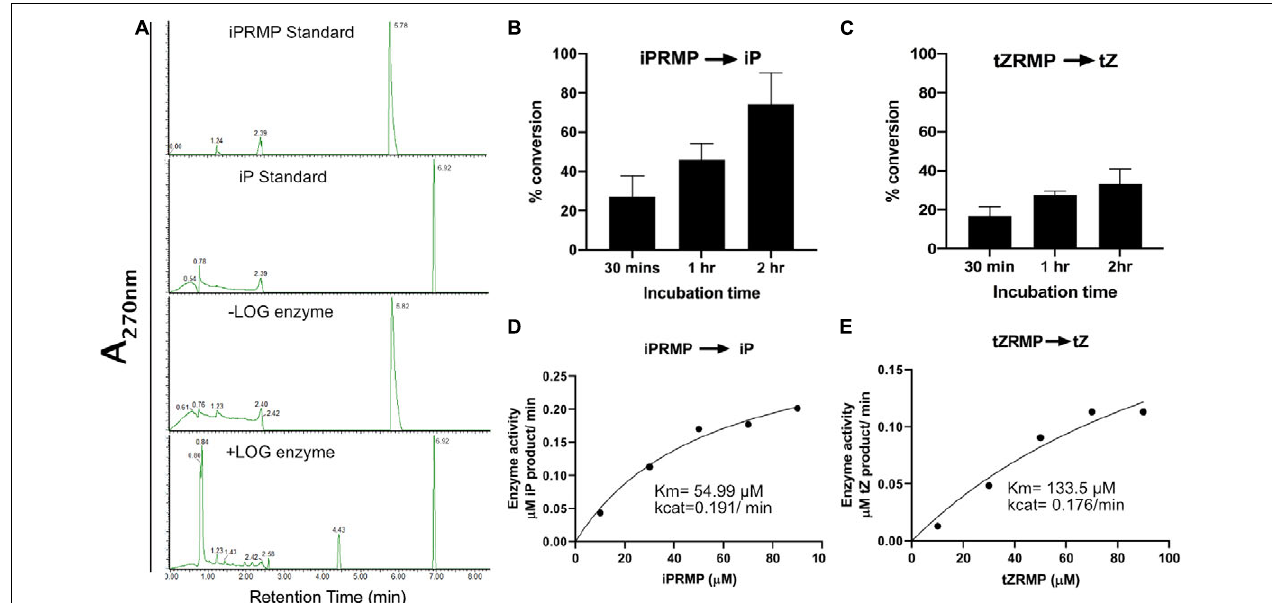
FIGURE 2 | Enzyme assay of CvarLOG1; detection and identification of reaction products. (A) Standards iPRMP and iP, reaction products of iPRMP without LOG and with LOG were separated by UHPLC. Phosphoribohydrolase activity of CvarLOG1 using the substrates (B) iPRMP and (C) t ZRMP as measured by UHPLC in terms of percent conversion; bars indicate ± SE ( n = 2). For control, a without enzyme sample was used. Determination of CvarLOG1 kinetic parameters for the conversion of (D) iPRMP to iP and (E) t ZRMP to